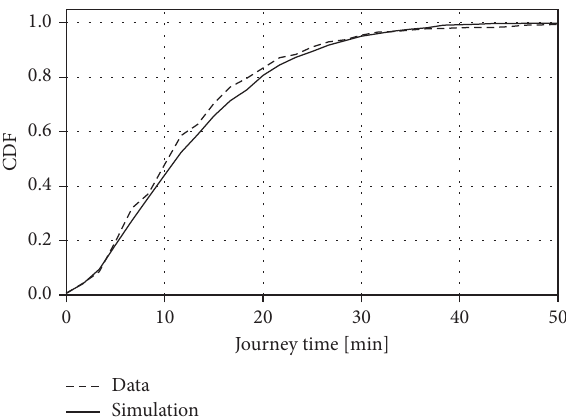
Figure 6: Comparison of journey times in simulation and in the original data set for Zurich